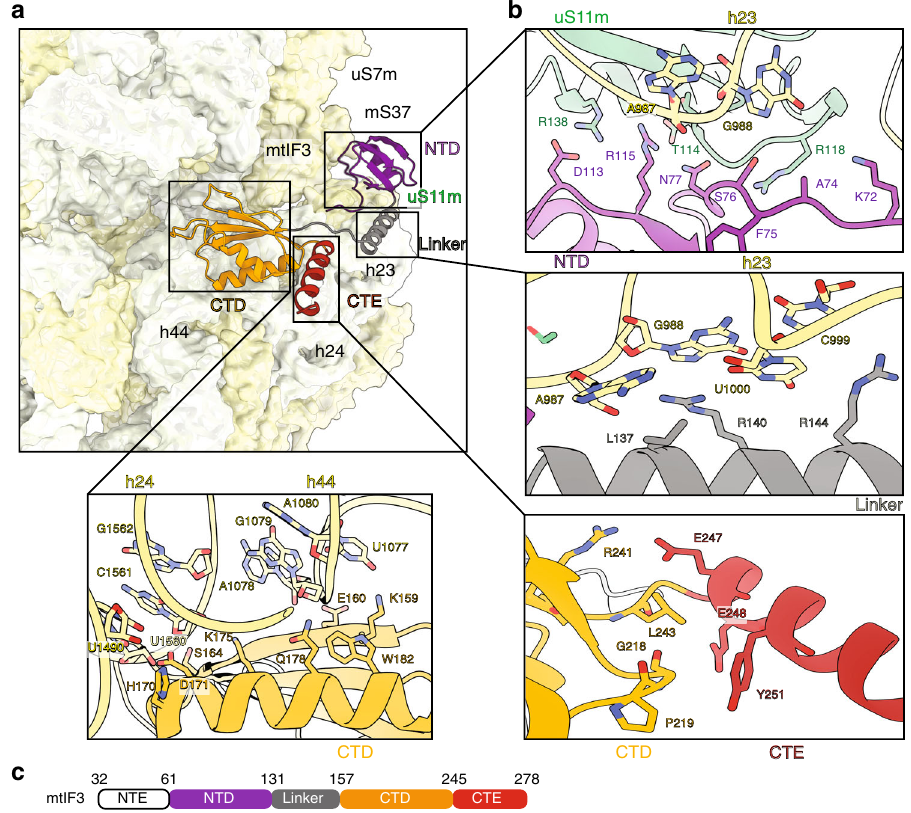
Fig. 2 Multiple interactions of mtIF3 with the mtSSU. a Domain organization of mtIF3 on mtSSU with mitochondria-speci fi c CTE (red) positioned outward from mtSSU. b Zoom-in panels for each of the mtIF3 domains featuring interactions with mtSSU. c Schematic representation of the mtIF3 with the corresponding color-code. NTE is disordered in the